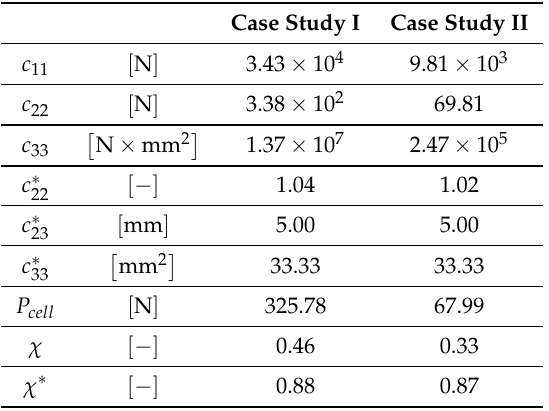
Table 2. Elasto-geometric coefficients of the equivalent beam model, cell’s critical loads and shear factors for the case studies I and